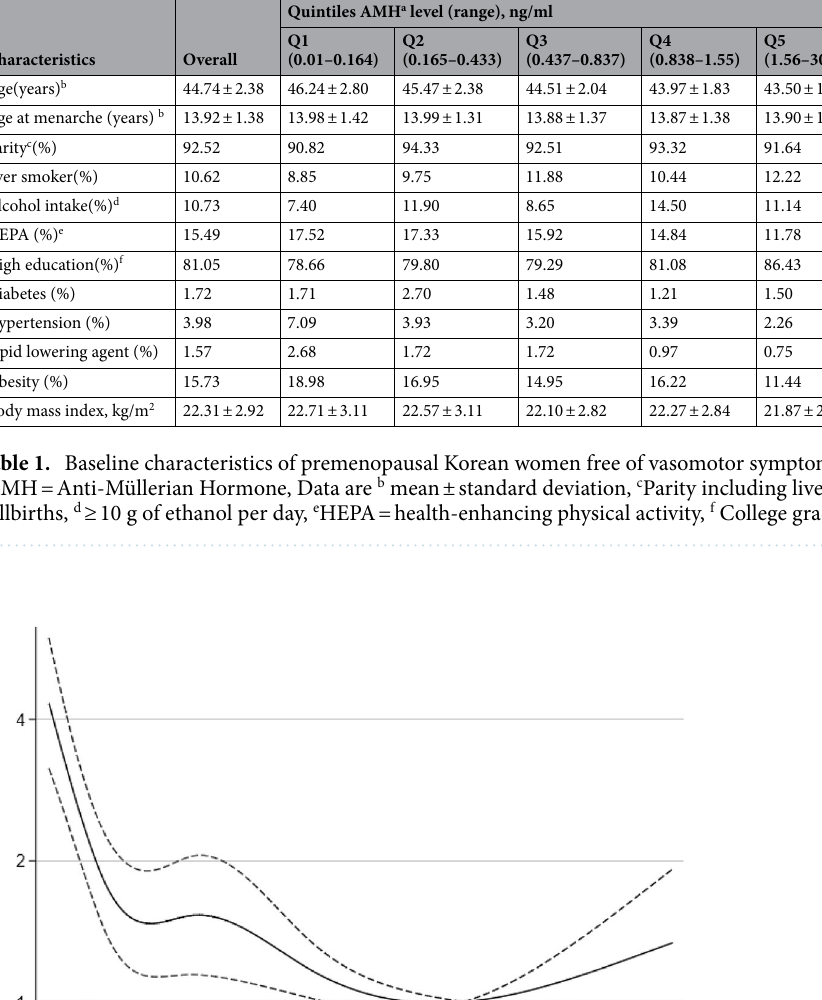
(Table S1). When we compared the characteristics of participants with successful follow-up with information on VMS and those lost to follow-up, those lost to follow-up were more likely to be older (Table S2). In analyses using inverse probability weights based on the determinants of having a follow-up visit over the study period to account for the possibility of selection bias, the results were very similar to the original results (Table S3). Subgroup analyses. The inverse association between the AMH level and incident VMS was consistently observed in subgroups without statistically significant interaction by age groups and the presence of overweight (Table 3). Multivariable-adjusted HR (95% CI) for incident VMS comparing the lowest AMH quintile to the